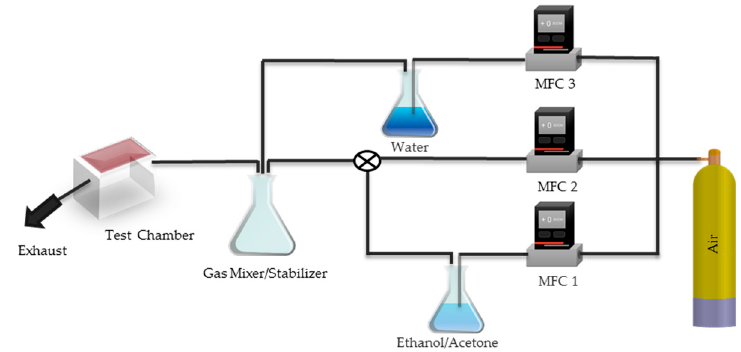
Figure 2. Schematic of sensor testing setup.